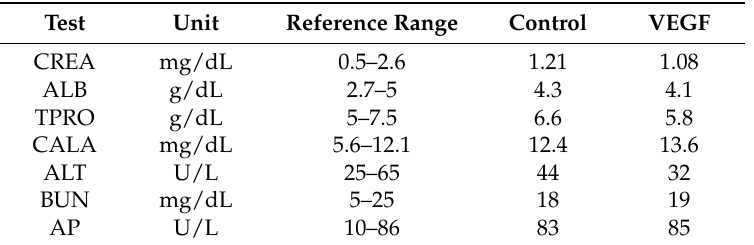
Figure 7. Histological analysis after intravitreal injection in rabbit retina. ( a ) Body weight increased as function of time after various treatment conditions. rabbits untreated with VEGF(control), rabbit groups treated with VEGF at dose of 100 µL (10 µg/mL). The body weight was obtained every day over a period of 7 days post-injection. The body weight was gradually increased for all treatment groups, and no difference was recognized between the treated and untreated groups, indicating that the VEGF at the applied doses are not toxic. Data expressed as mean ± SD (N = 4, p < 0.01). ( b ) H&E-stained images of retinal neovascularizarion (RNV) obtained from various groups: control ( b ), and treatment ( c ). The histological change and RNV development were observed at: ( c ) ×20 and ( d ) ×40. Table 1. Mini chemistry test results.